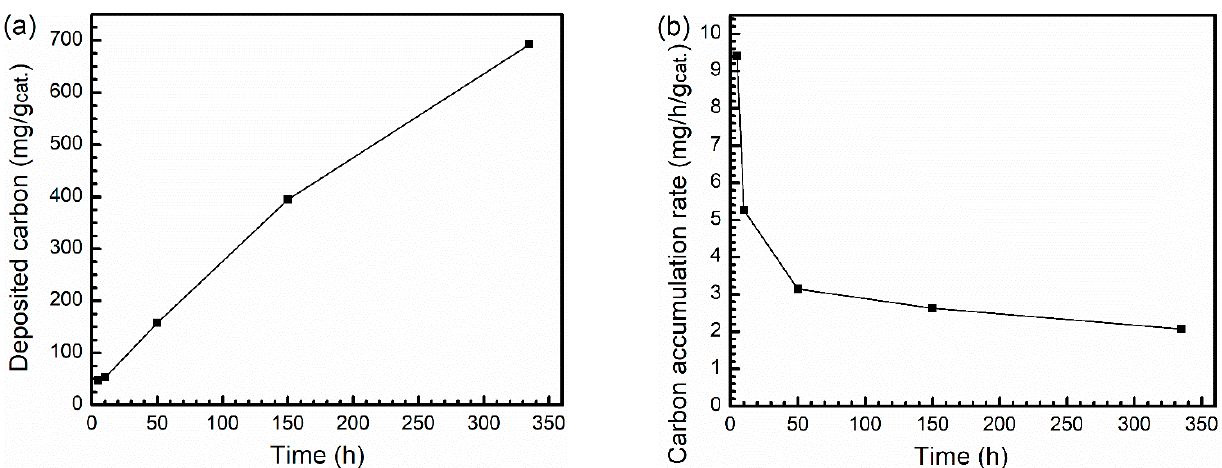
Figure 9. ( a ) The amount of carbon deposits over Ni/MgAl 2 O 4 -E catalyst after different reaction time and ( b ) the average accumulation rate of carbon deposits as a function of reaction time over Ni/MgAl 2 O 4 -E catalyst.